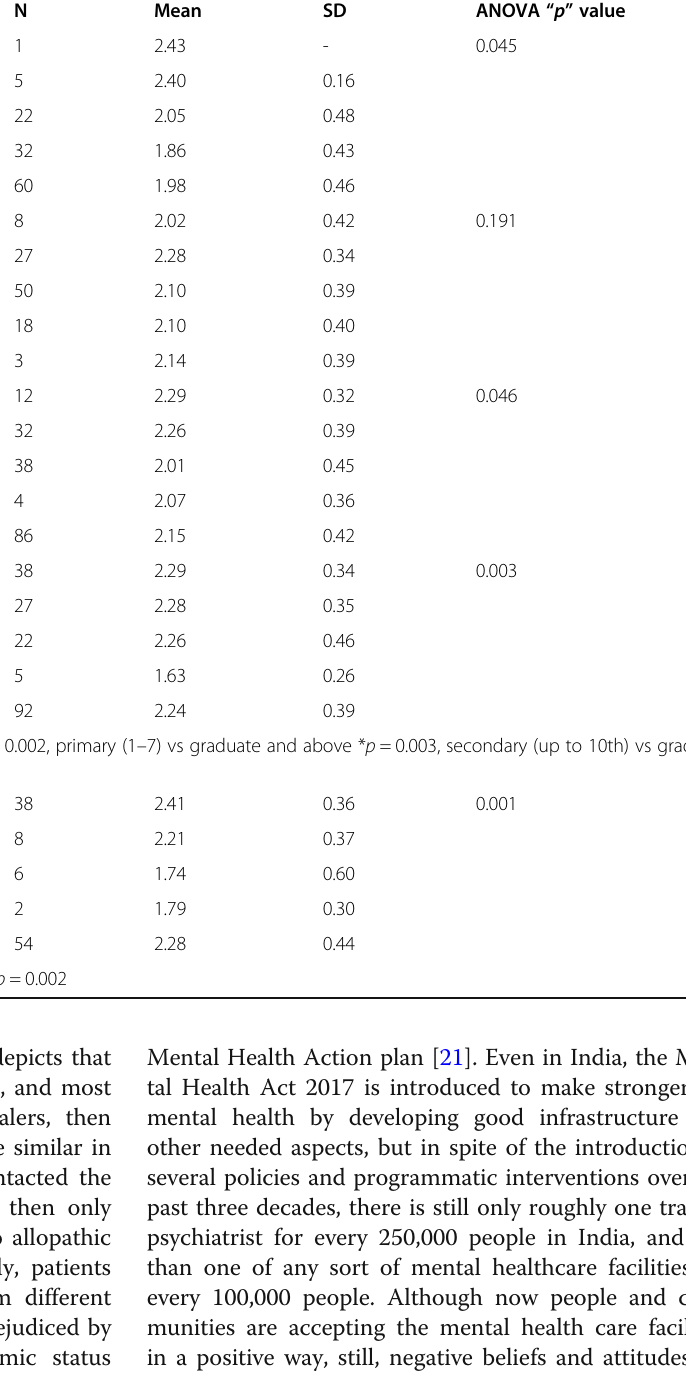
Table 4 Comparison of public attitude score towards mental healthcare facilities by education level within age group Age group in years Education